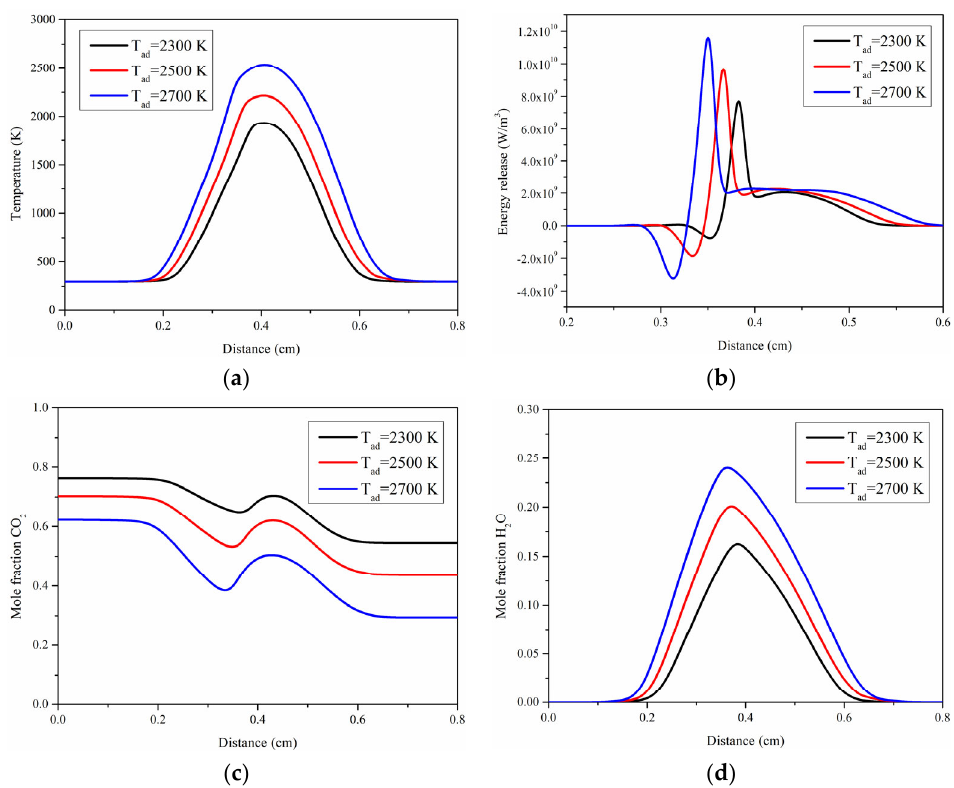
Figure 12. The distributions of temperature ( a ), heat generation ( b ), CO 2 mole fraction ( c ), and H 2 O mole fraction ( d ) in cases 1.3, 2.2, and 3.1.